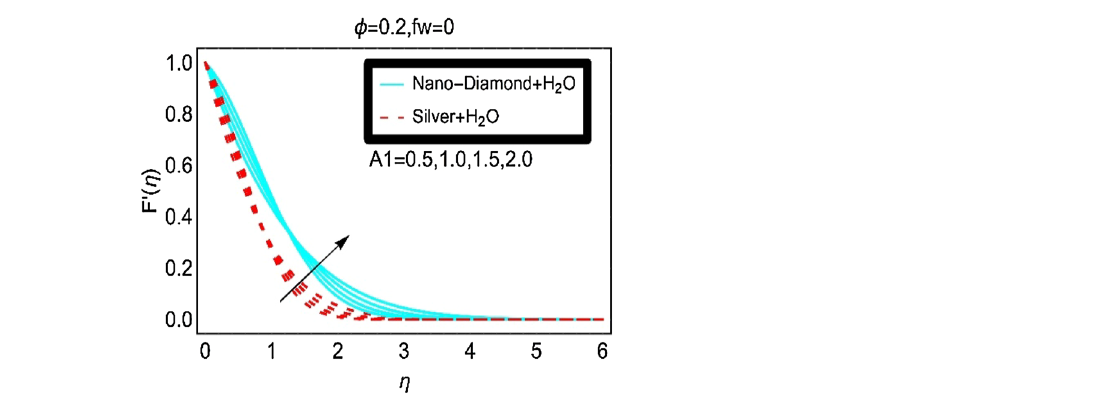
0 for varying A =